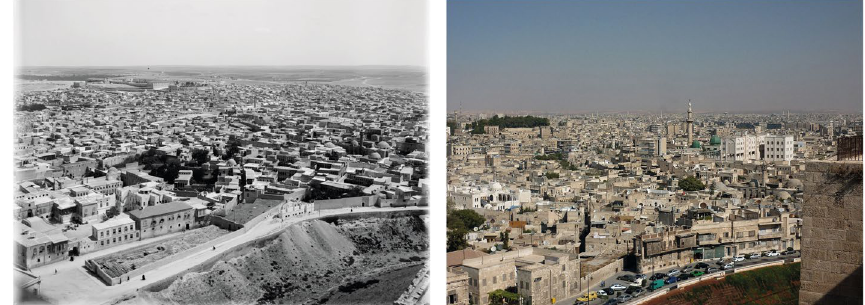
Fig. 6 Left: Skyline of Aleppo, taken from Aleppo’s Citadel, possibly in the 1940s. (Sources: Aleppo from the citadel [between 1898 and 1946]. Retrieved 12 August 2020 from Library of Congress https:// www. loc. gov/ pictu res/ item/ 20196 98853). Right: Skyline of Aleppo, taken from Aleppo’s Citadel in 2009 (Source: Blick auf Aleppo von der Zitadelle aus . Retrieved 12 August 2020 from https:// de. wikip edia. org/ wiki/ Alepp o#/ media/ Datei: Aleppo.